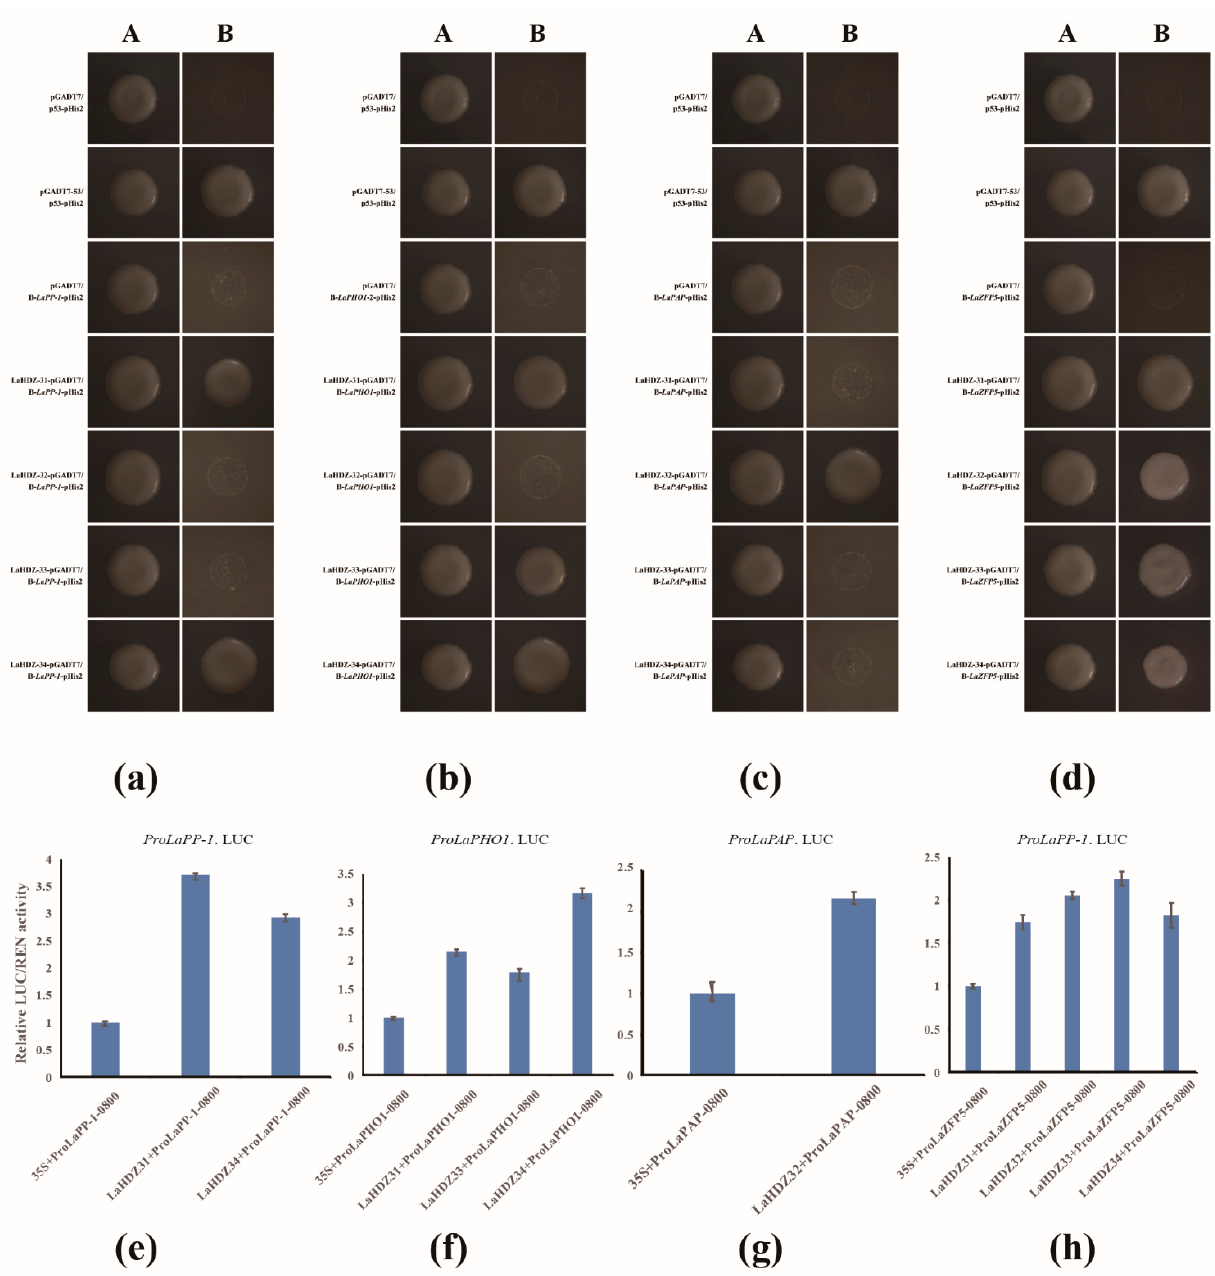
Figure 11. Binding of LaPP-1 , LaPHO1 , LaPAP , and LaZFP5 promoters by LaHDZ31–34. Yeast one-hybrid assays of LaHDZ31–34 and the promoters of ( a ) LaPP-1 , ( b ) LaPHO1 , ( c ) LaPAP , and ( d ) LaZFP5 , based on the transcriptomic analysis of Larix kaempferi . A: SD/-Leu-Trp; B: SD/-Leu-Trp-His containing 30 mmol/L 3-AT. Dual-luciferase assay of LaHDZ31–34 on ( e ) LaPP-1 , ( f ) LaPHO1 , ( g ) LaPAP , and ( h ) LaZFP5 .